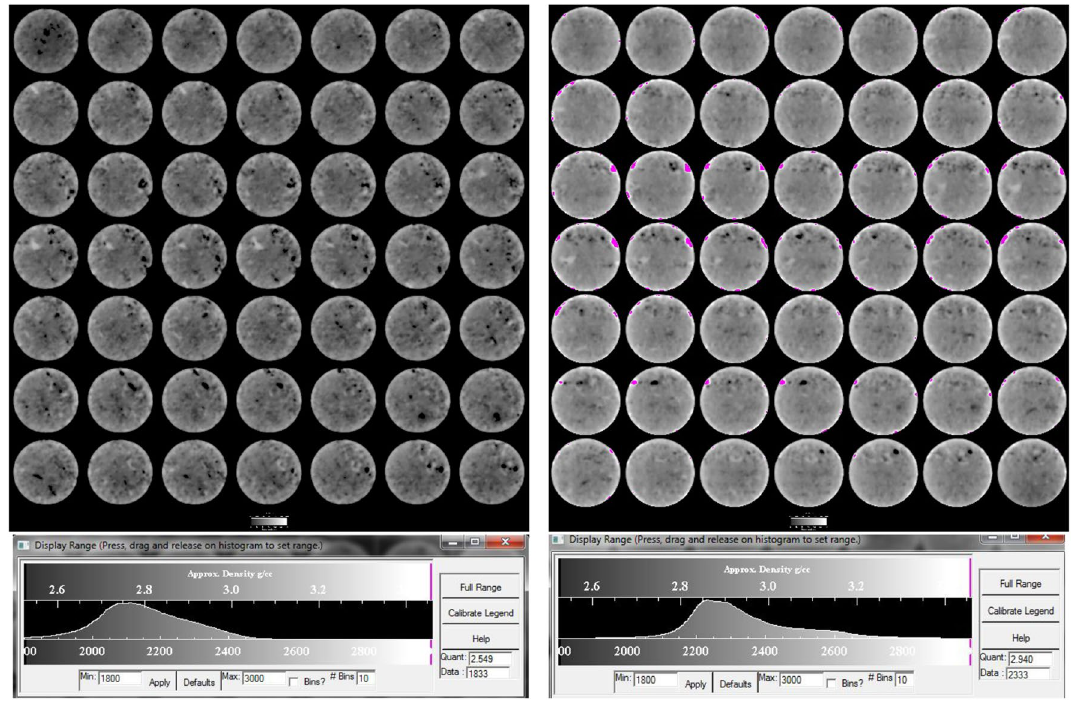
Fig. 16 CT scan of sample 4 showing: (left) pre-filtration-loss slices and (right) post-filtration-loss